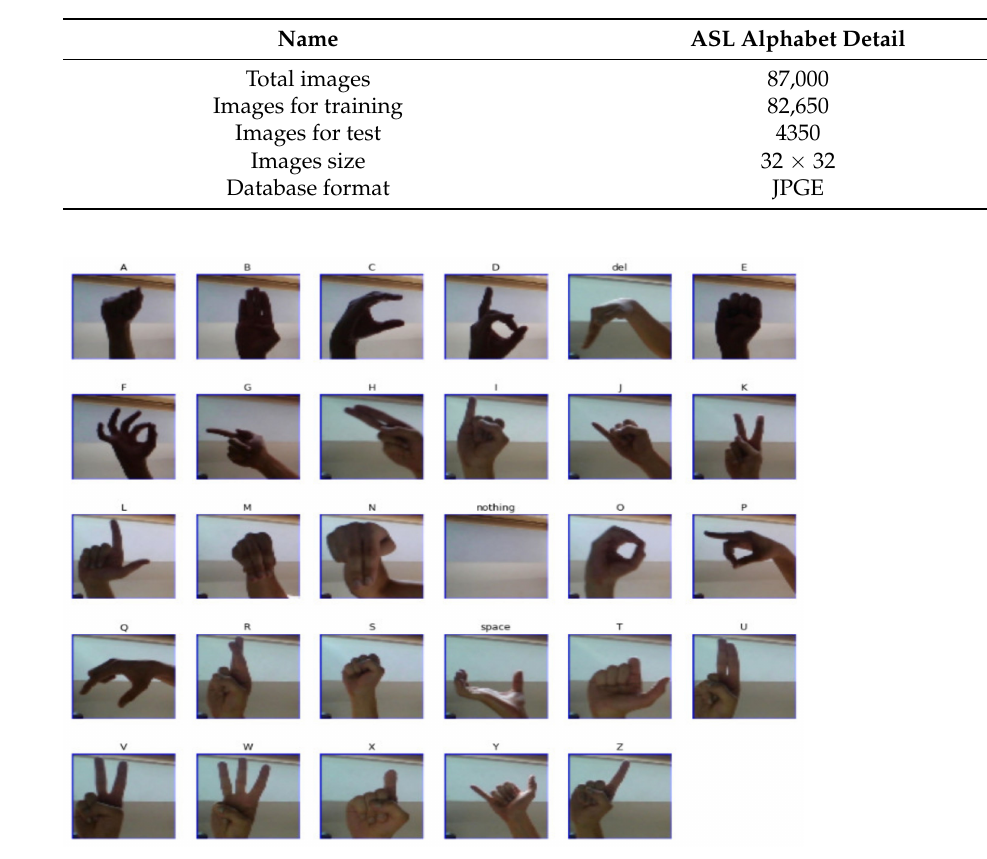
Table 5. ASL Alphabet database description.